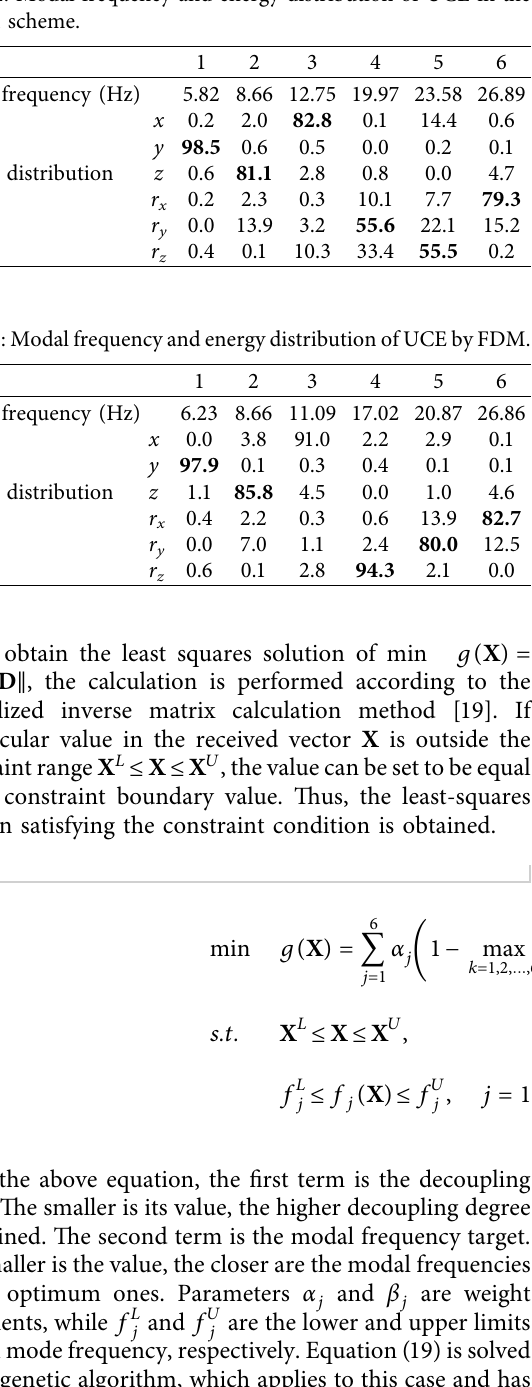
Table 4: Modal frequency and energy distribution of UCE by IDM.